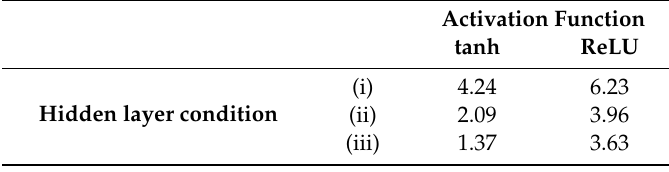
components. Table 5. RMSE (MPa) for test data in six neural network conditions.